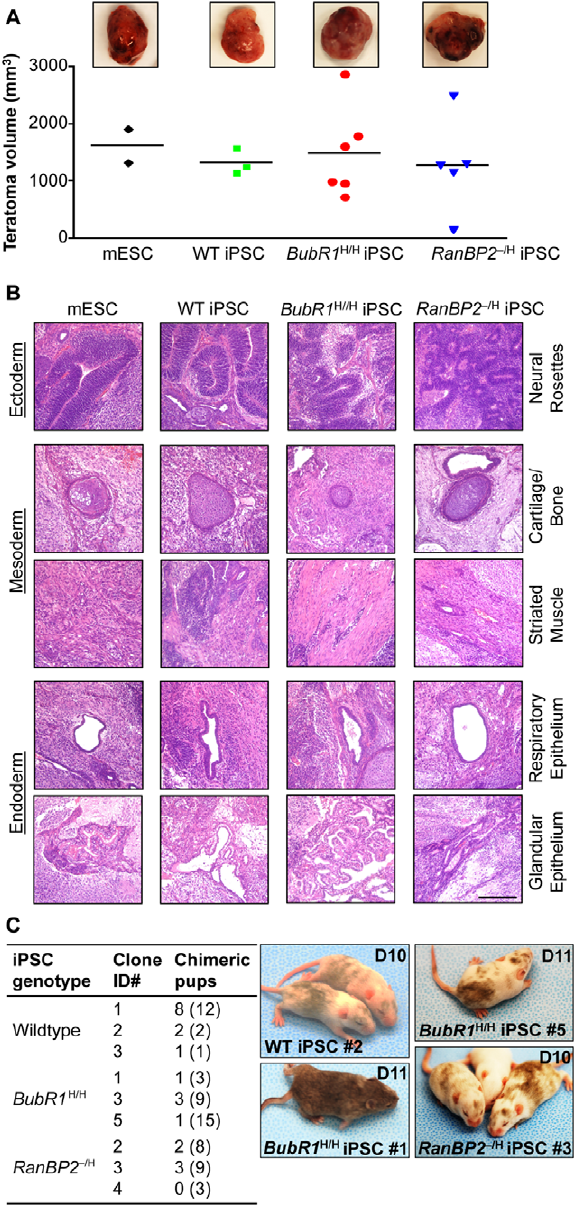
Figure 3. iPSCs derived from W-CIN MEFs form teratomas and chimeric mice. (A) Analysis of teratomas derived from iPSC clones of the indicated genotypes. mESCs were used as a control for teratoma formation. (Top) Images of representative teratomas collected 21 days after injection of iPSCs into SCID mice. (Bottom) Teratoma volume plotted as a scatter plot with mean. We note that RanBP2 –/H and BubR1 H/H MEFs failed to form teratomas. (B) Hematoxylin and eosin staining of teratoma sections. Scale bar is 200 m m. (C) Aneuploid iPSCs injected into BALB/c host blastocysts produce viable chimeric mice. (Left) Summary of blastocyst injection results. Clone ID # s correspond to iPSC clones listed in Table 2. Numbers in parenthesis indicate total number of pups delivered. (Right) Images of chimeric animals produced by blastocyst injection of iPSCs. The ages of the pups are indicated in